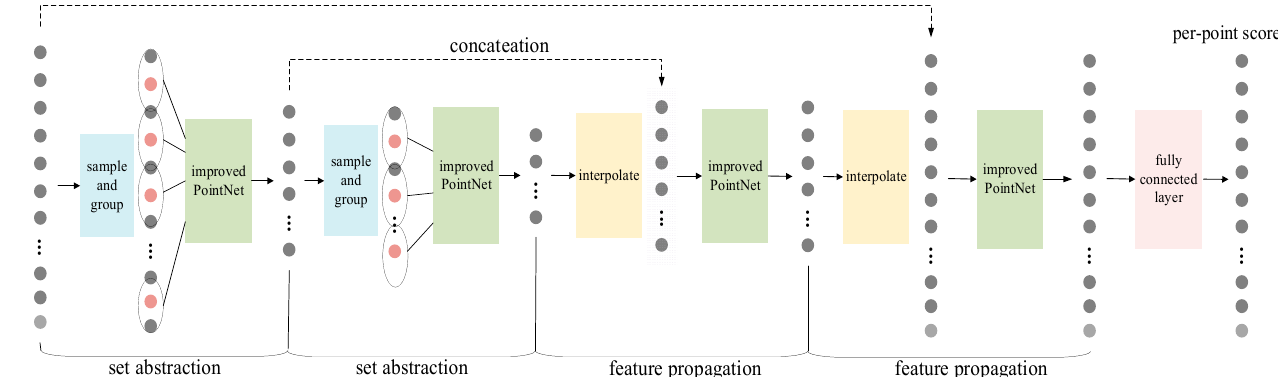
Figure 1. The HPRS framework based on hierarchical structures for point cloud segmentation.